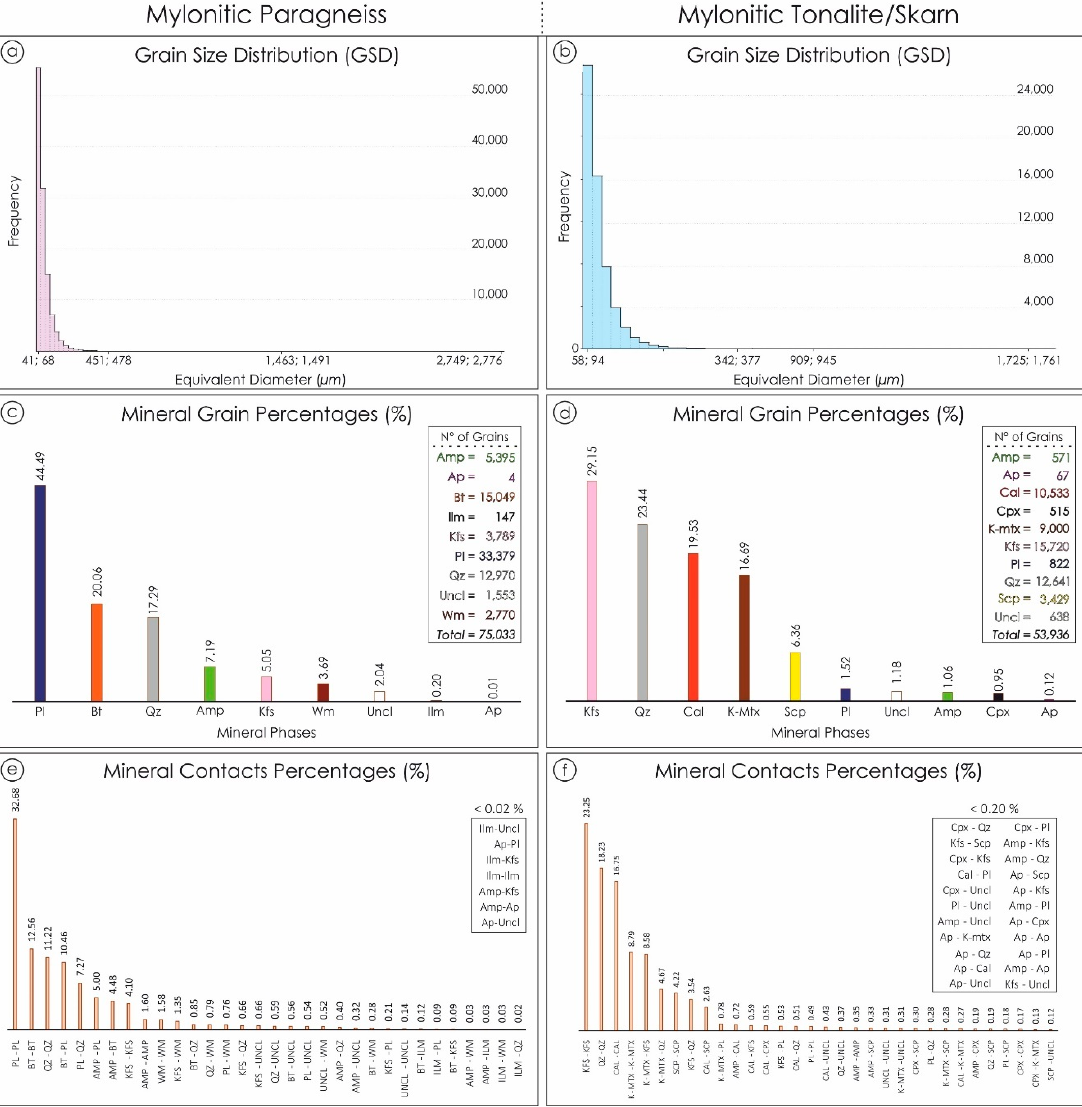
Figure 10. Quantitative data extraction performed via Micro-Fabric Analyzer for the mylonitic paragneiss ( a , c , e ) and tonalite ( b , d , f ): ( a , b ) grain size distribution on the basis of the equivalent diameter (see Appendix A) of the grains; ( c , d ) mineral grain percentages and the total number of mineral grains; ( e , f ) percentages of couples of mineral contacts. Mineral abbreviations from [46]. Uncl = Unclassified phase; K-mtx = potassium-rich matrix.